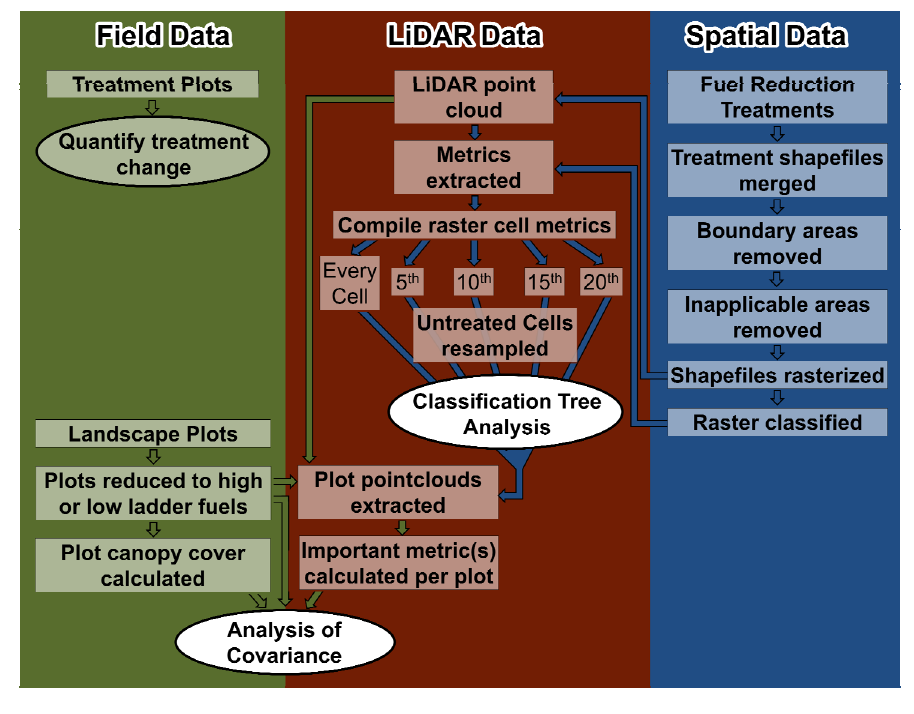
Figure 2. Project work flow, including all data sources and methods; analysis products are shown in ovals; data sources and intermediate steps are shown in